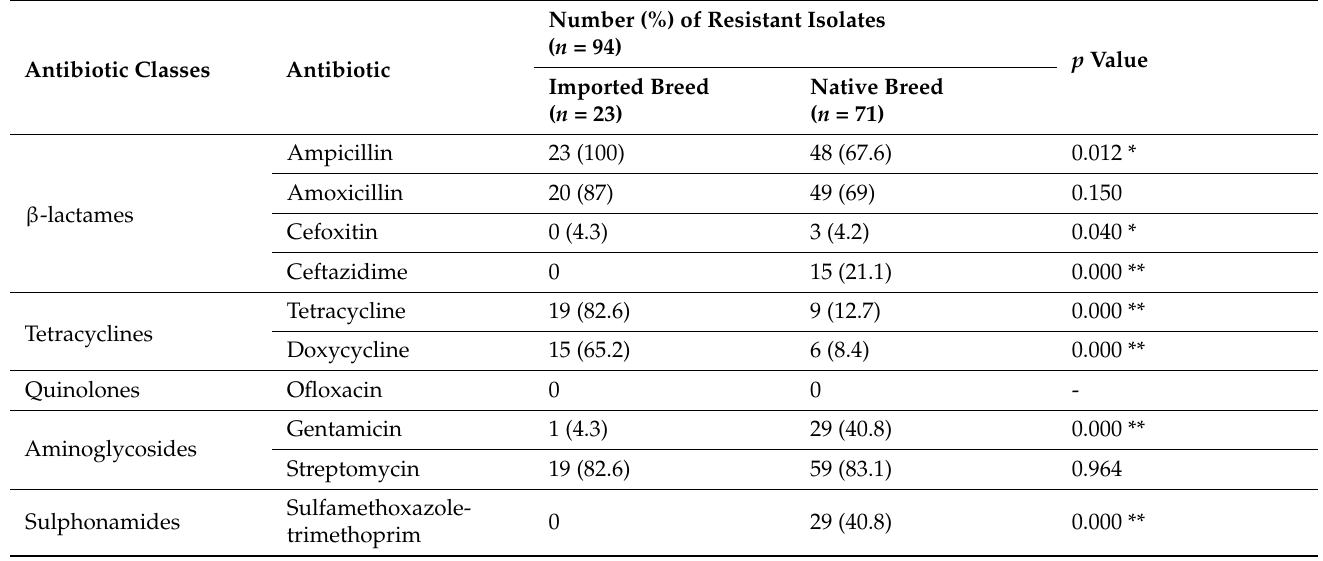
Table 2. Numbers and percentages of Salmonella enterica isolates resistant to tested antibiotics.